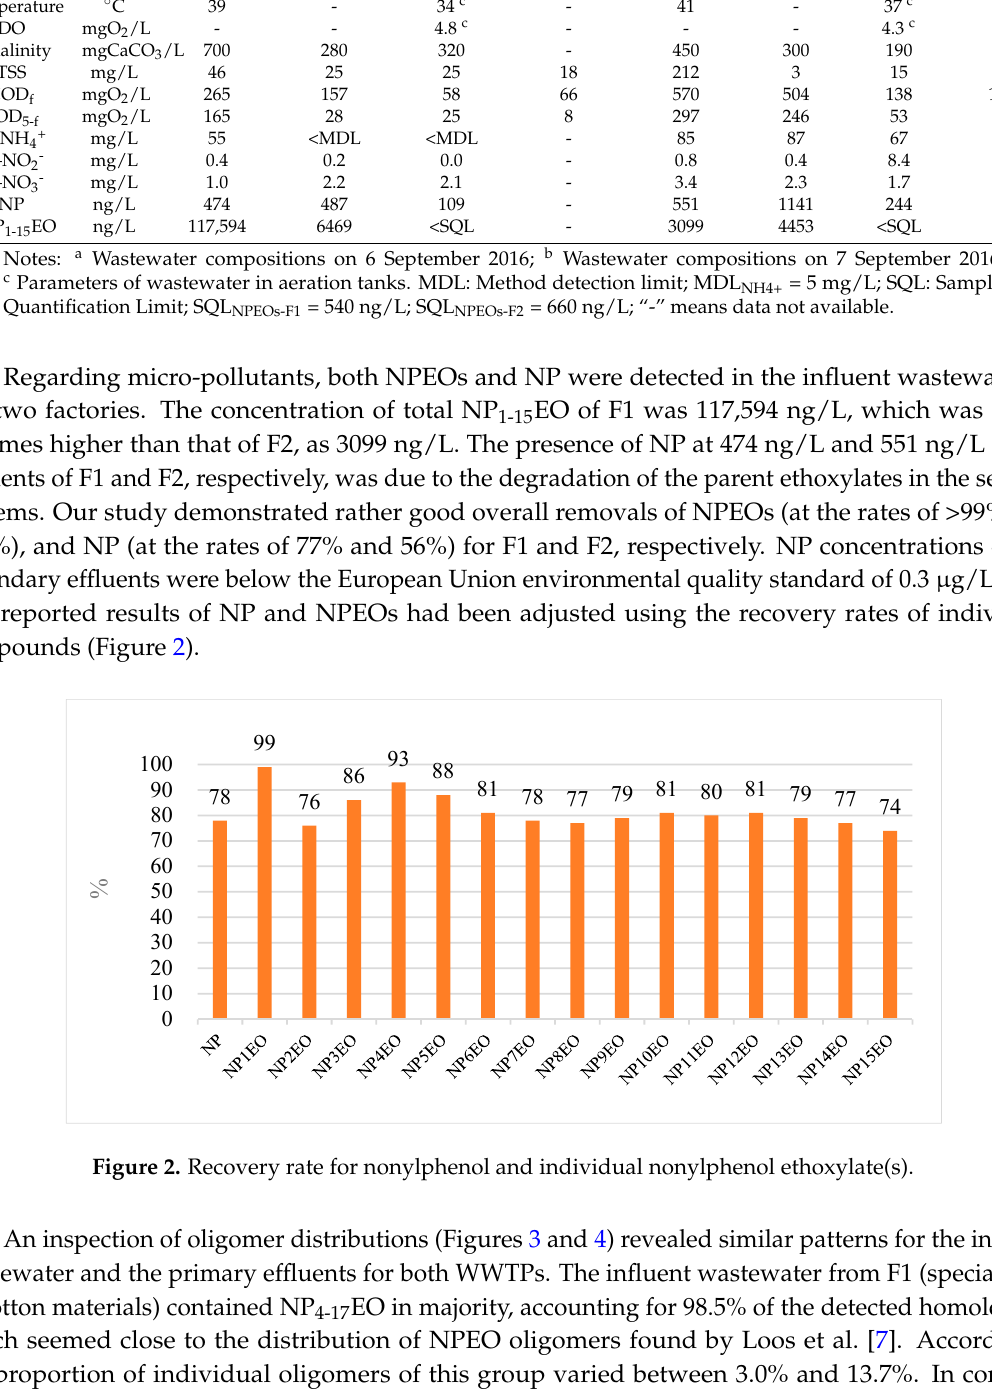
Table 4. Wastewater compositions after each treatment process.